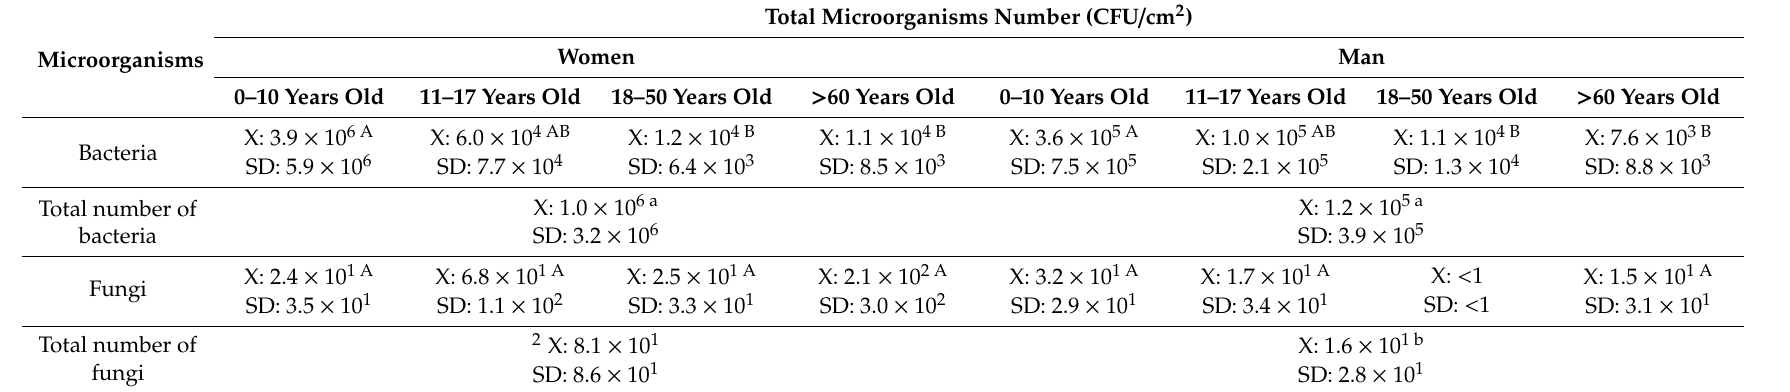
Table 1. Total number of bacteria and fungi depending on age and gender factors.